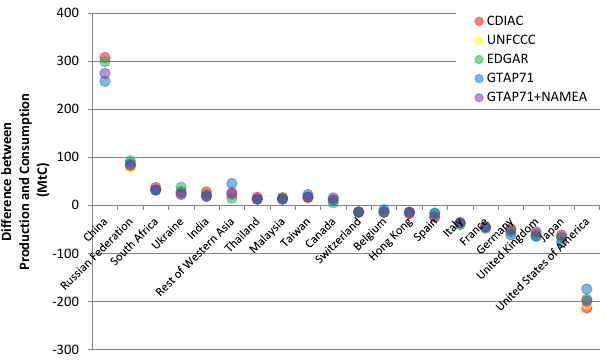
Fig. 5. The difference between Production and Consumption for the 20 countries with the largest differences for the CDIAC database (2004). The results are shown for all the databases. Note that UN- FCCC only has values in Annex I